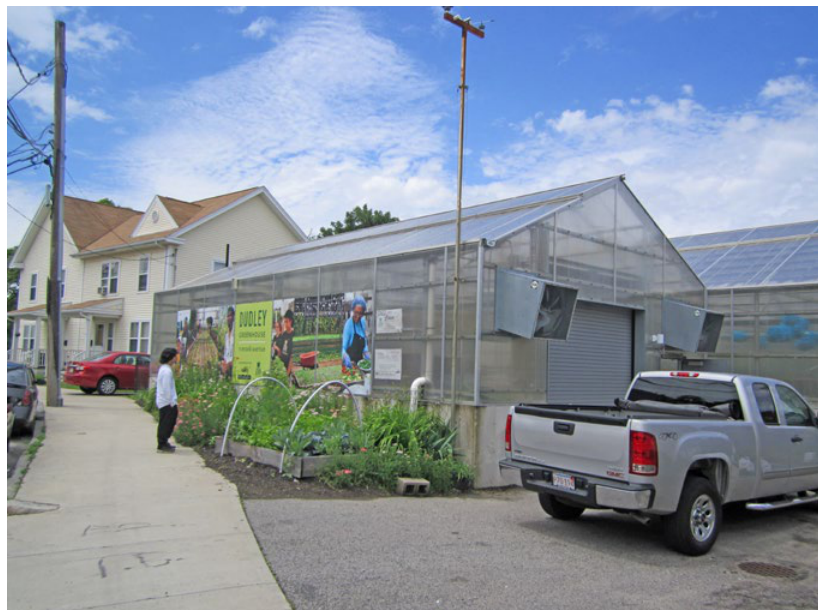
Figure 3. Growing your own activists, Dudley